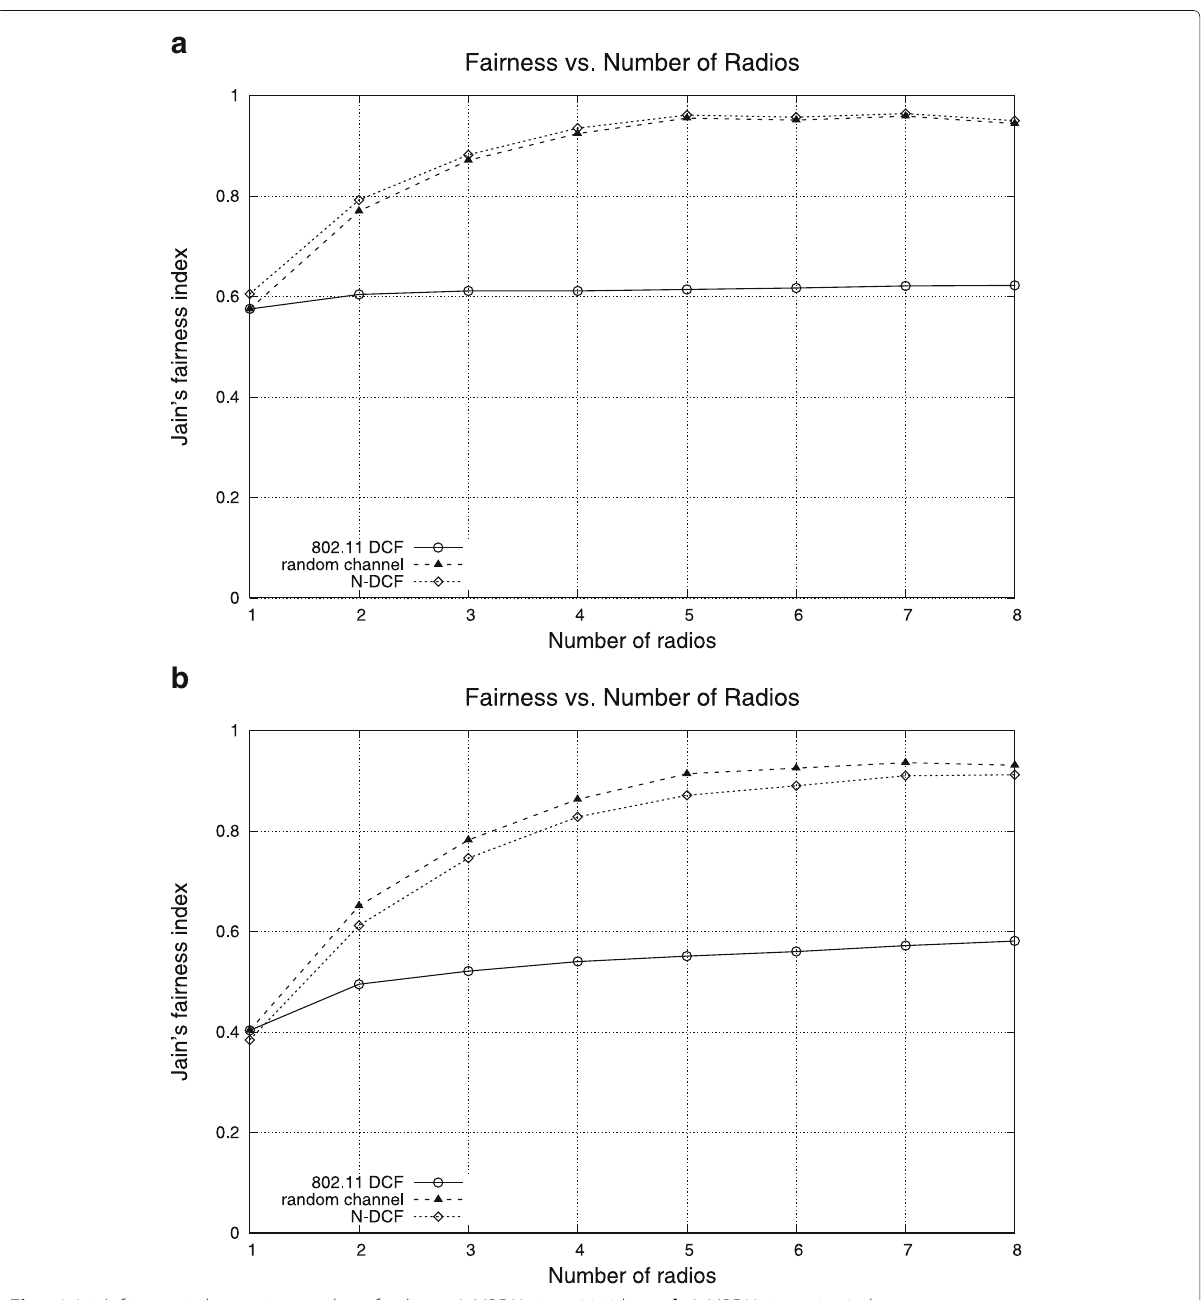
Fig. 13 Jain’s fairness index varying number of radios. a A-MPDU size = 3000 bytes. b A-MPDU size = 65,535